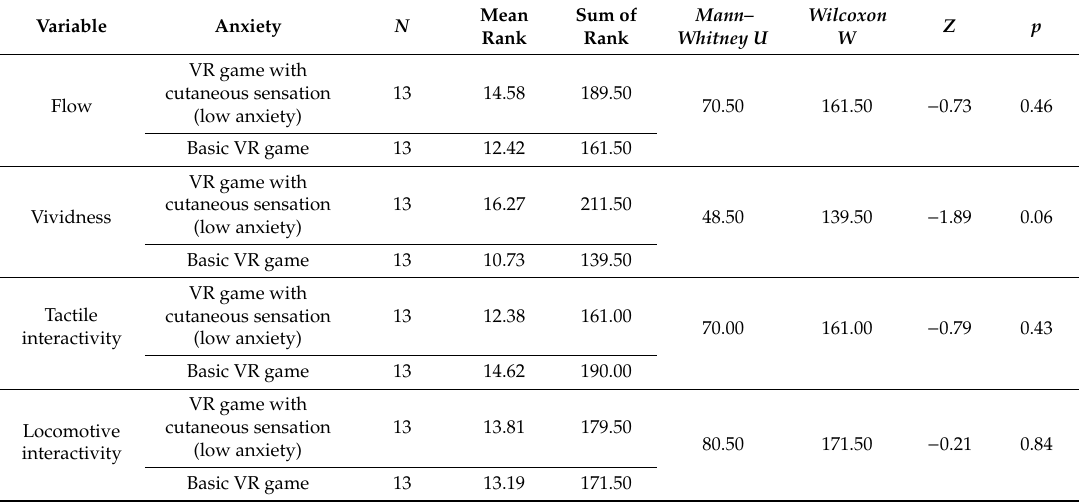
Table 8. Results of the Mann–Whitney U test analysis for all the variables of the low-anxiety group while playing the fire safety education VR game with cutaneous sensation and the group that played the basic fire safety education VR